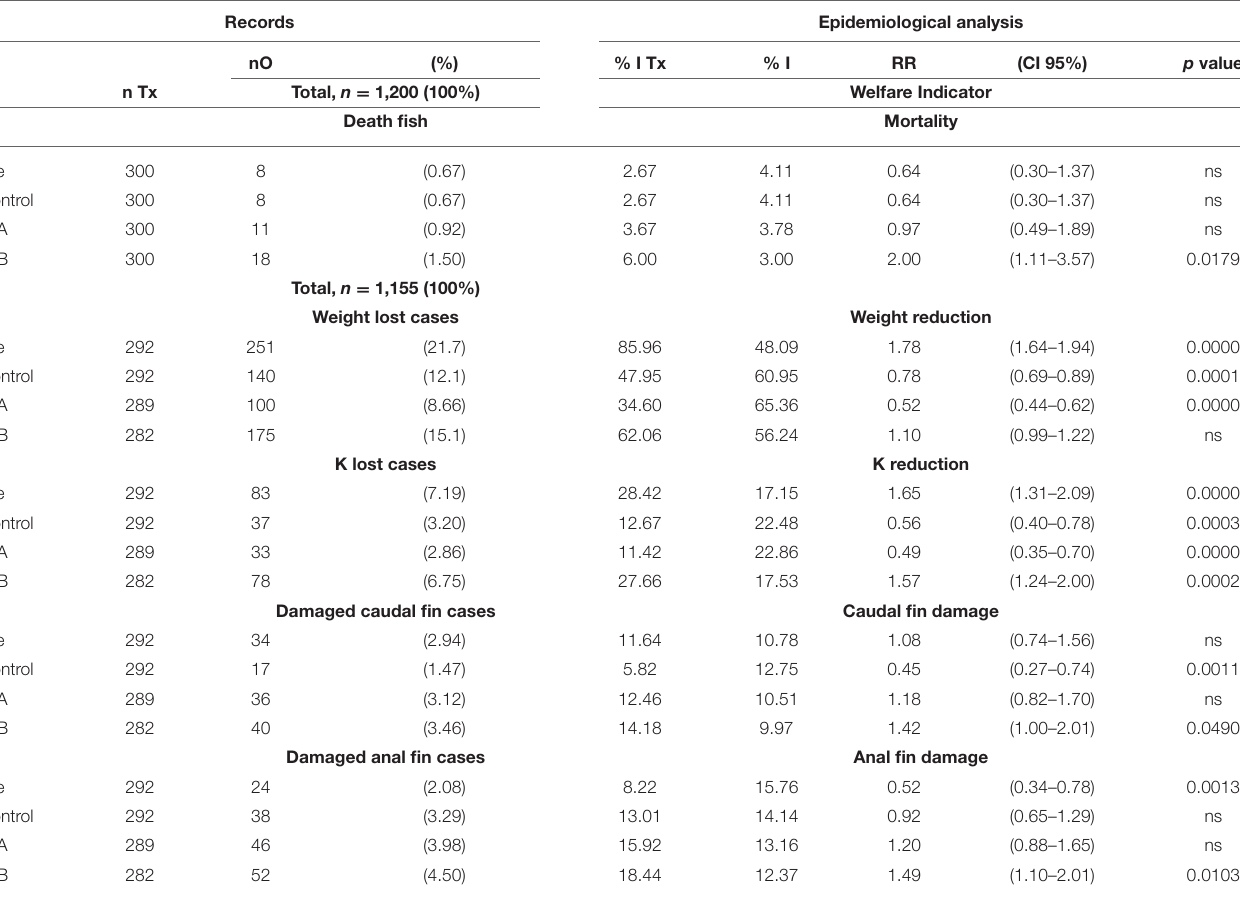
TABLE 5 | Contingency table, incidence of mortality, weight reduction, K reduction, and caudal and anal fin damage of O. niloticus juvenile according to the feeding